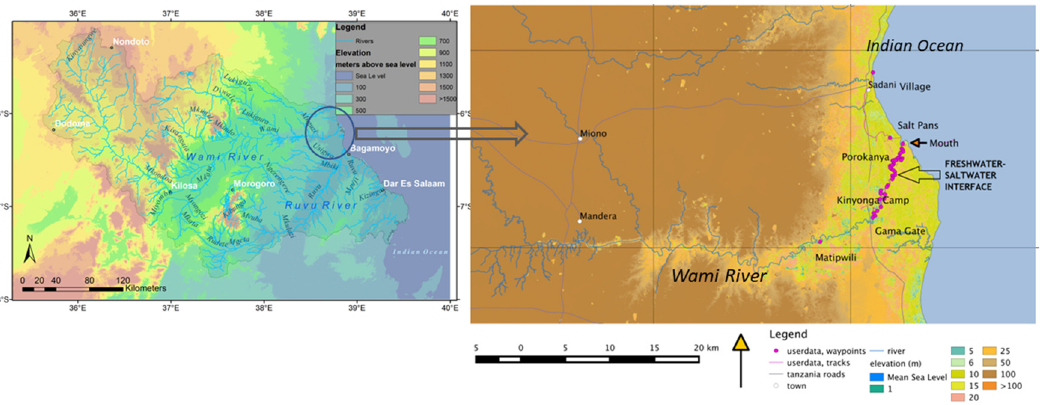
Figure 1. Left —Wami River Basin in Tanzania. Right —the estuarine section on Wami River that starts from Matpiwili and Gama Gate, past Porokanya, flowing on towards the mouth at the Indian Ocean.